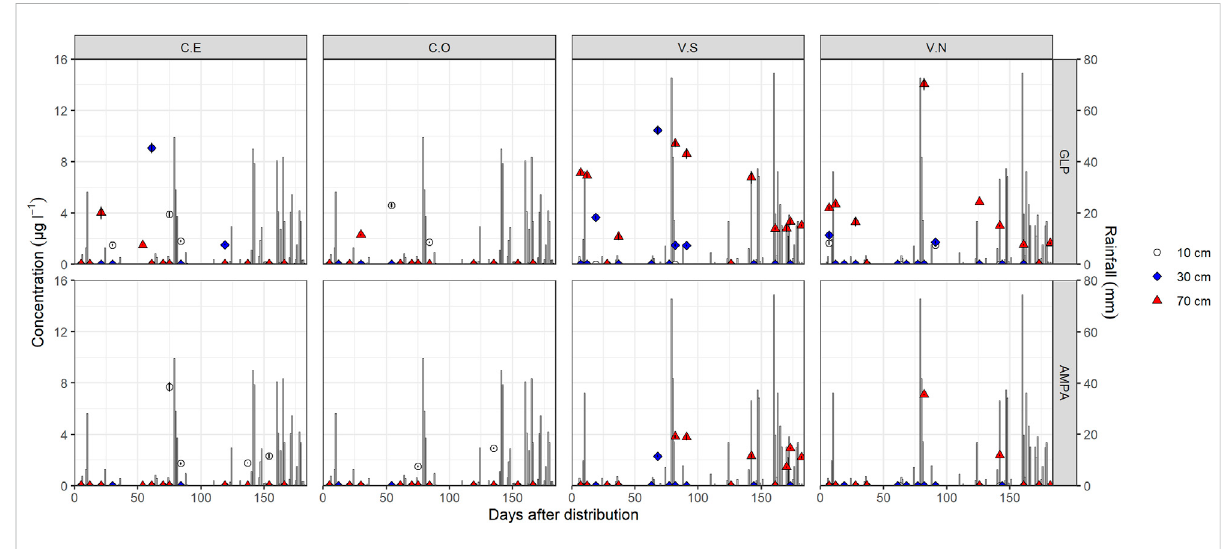
FIGURE 3 Glyphosate and AMPA detection in soil pore water samples in different monitoring stations and depths. Bars identify daily rainfall events. Data < LOQ are reported in the graphs equal to zero.